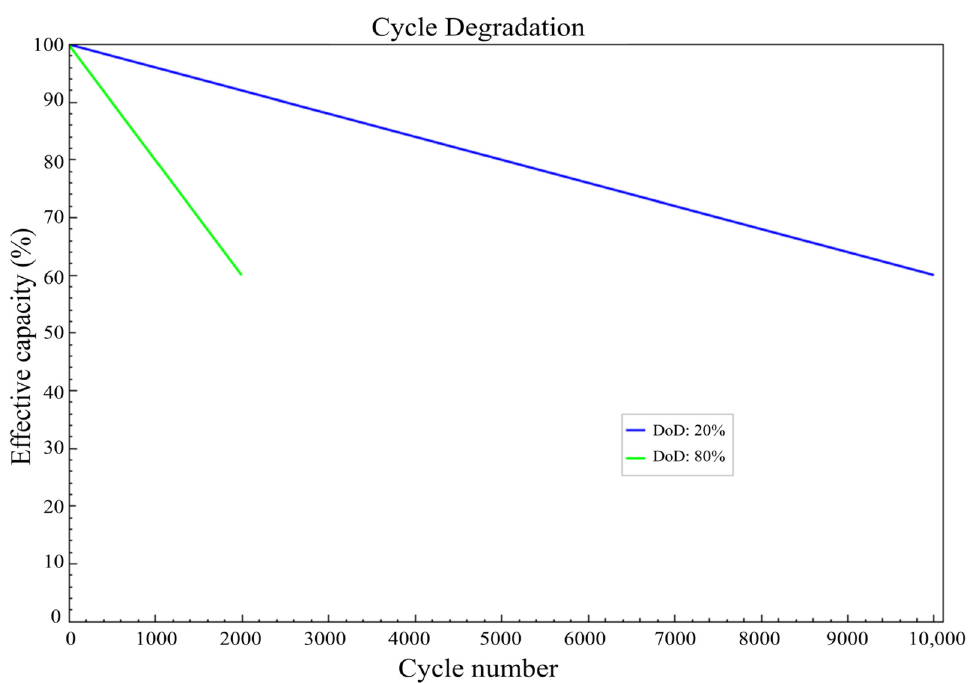
Figure 4. Battery degradation in SAM in relation to the depth of discharge (DoD) and battery cycle. The blue line indicates the degradation rate at a DoD of 20% (80% of its initial state remaining at a minimum), and the green line indicates a DoD of 80% (20% of its initial state remaining at a minimum).